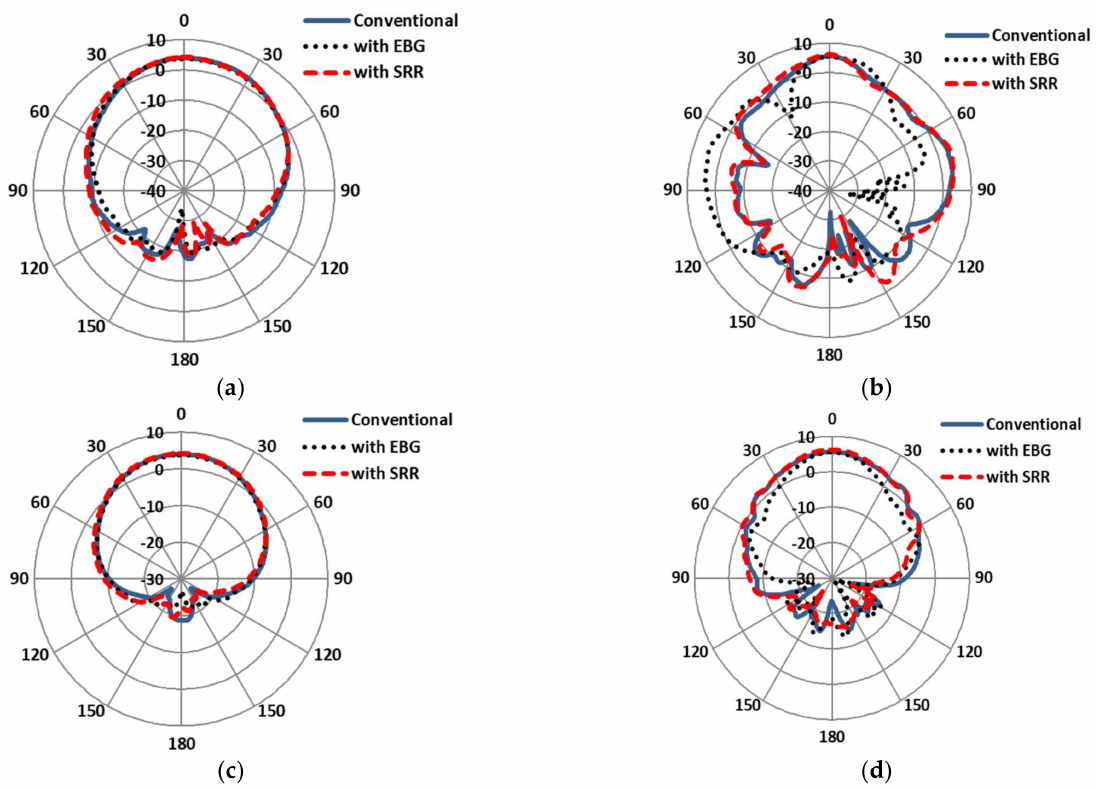
Figure 19. Gain patterns comparisons of conventional antenna under bent condition (on-body). ( a ) E-plane at 2.4 GHz. ( b ) E-plane at 5.4 GHz. ( c ) H-plane at 2.4 GHz. ( d ) H-plane at 5.4